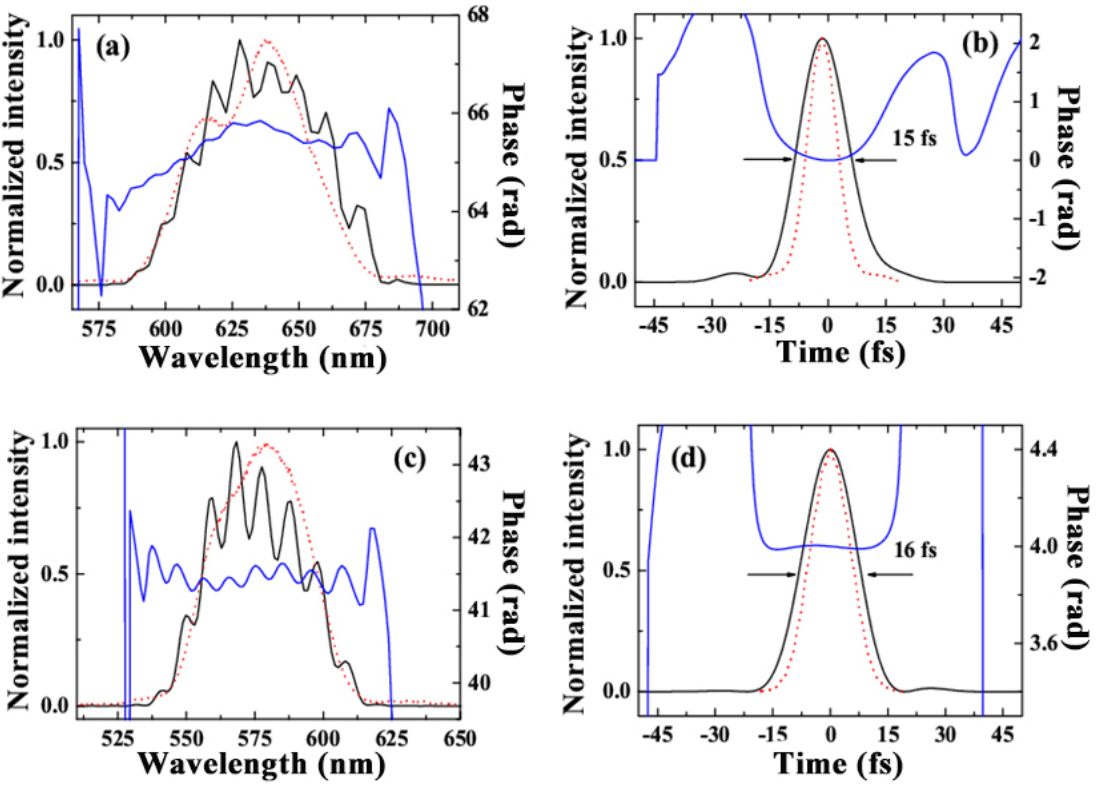
Figure 9. ( a ) Measured (red), retrieved (black) spectral intensity profile and retrieved spectral phase (blue) of AS1; ( b ) Retrieved temporal intensity profile (black), temporal phase (blue), and calculated transform-limited temporal intensity profile (red) of AS1; ( c ) Measured (red), retrieved (black) spectral intensities and retrieved spectral phase (blue) of AS2; ( d ) Retrieved temporal intensity profile (black), phase (blue), and calculated transform-limited temporal intensity profile (red) of AS2